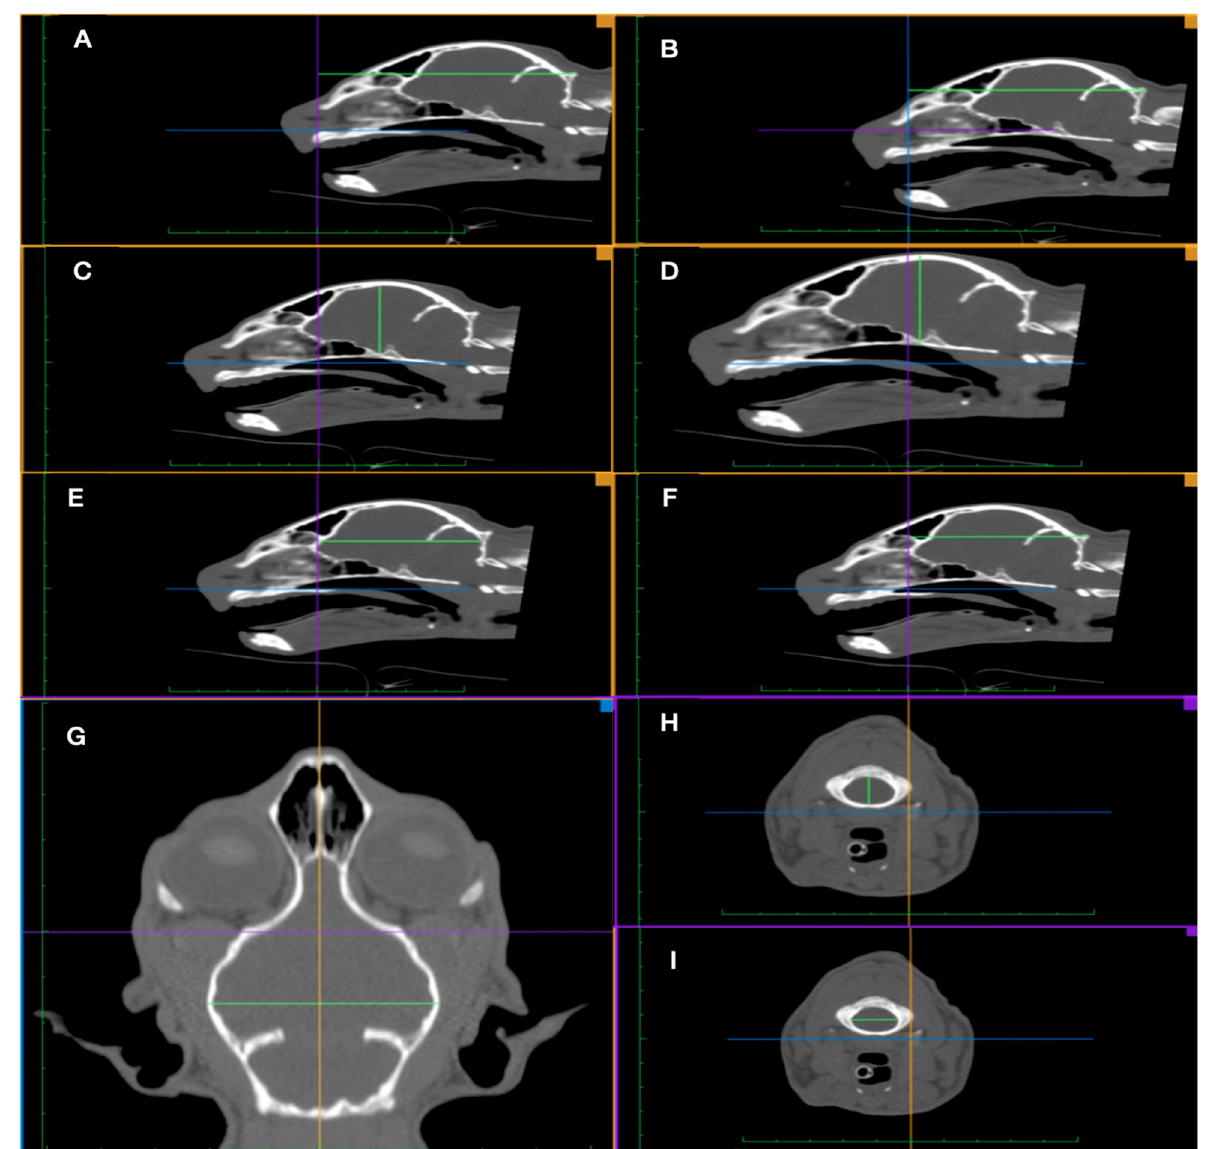
Figure 1. Schematic representation of the measurements and anatomical landmarks used for the morphometric study of the skull and cranium. ( A )—Skull length (SL), in the sagittal plane, from the rostral border of the nasal bone to the external occipital protuberance (this is subdivided between cranial and nasal length). ( B )—Cranial length (CL), in the sagittal plane, from the external occipital protuberance to the caudal limit of the nasal bone. ( C )—Internal height of the cranium (IHC), in the sagittal plane, from the deepest indentation of the sella turcica directly dorsal to the inner layer of the base of the cranium to the most dorsal surface of the cranium. ( D )—External height of the cranium (EHC), in the sagittal plane, being identical to the IHC but in the external face of the bone surfaces in question. ( E )—Internal length of the cranium (ILC), in the sagittal plane, from the deepest indentation of the fronto-ethmoidal junction to the middle of the distal surface of the cranium at the level of the cerebral surface of the external occipital protuberance. ( F )—External length of the cranium (ELC), in the sagittal plane, being identical to the ILC but of the external surface of the bones in question. ( G )—Cranial width (CW), in the dorsal plane, between the two most lateral points of the cranium. ( H )—Width of the foramen magnum (FMW), in the transverse plane, by the identification of the two parallel points more lateral of the foramen magnum. ( I )—Height of the foramen magnum (FMH), in transverse plane, with the vertical height being obtained in the center of the foramen magnum. In order to perform the linear measurements (Figure 1), the images were centered and aligned based on the following anatomical reference points: the temporomandibu- lar joint and/or tympanic bulla in the transverse plane, the hard palate in the